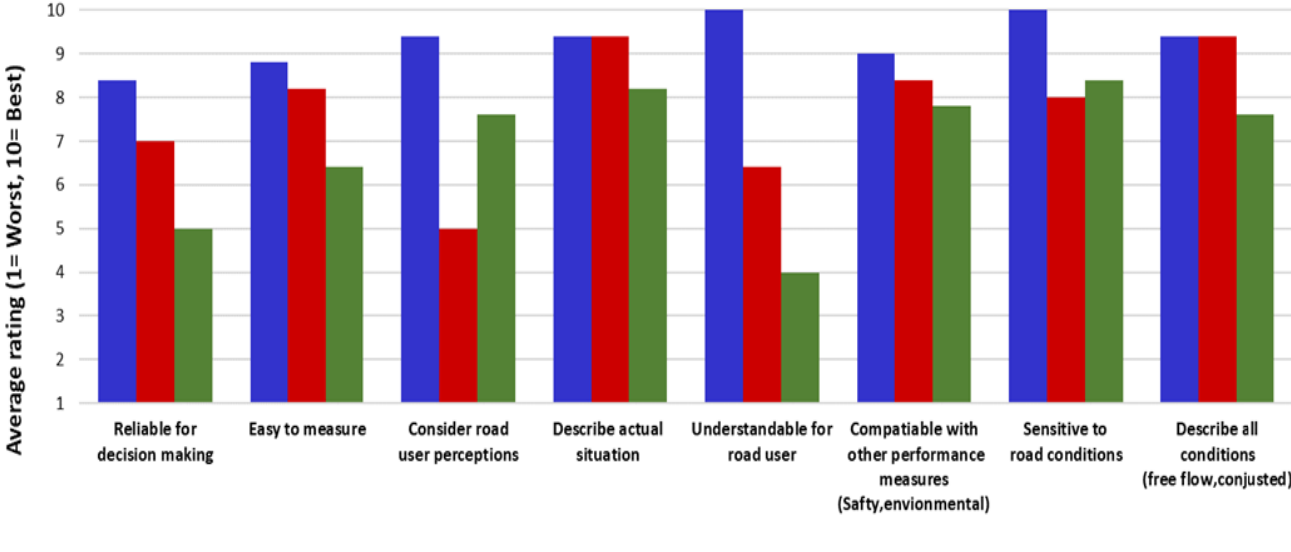
Figure 3. Expert Ranking of Mobility Performance Measures.